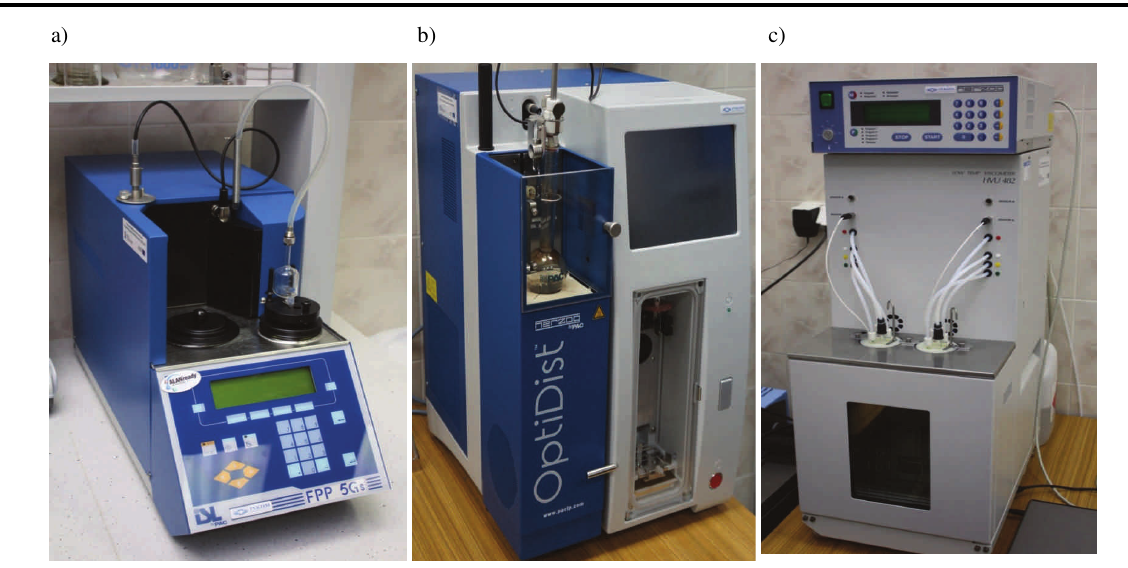
Fig. 1. Research devices: (a) FPP 5Gs Automated Cold Filter Plugging Point Analyzer; (b) OptiDist Automated Distillation Analyzer for Refining; (c) HVU 482 Automated Ubbelohde Viscometer